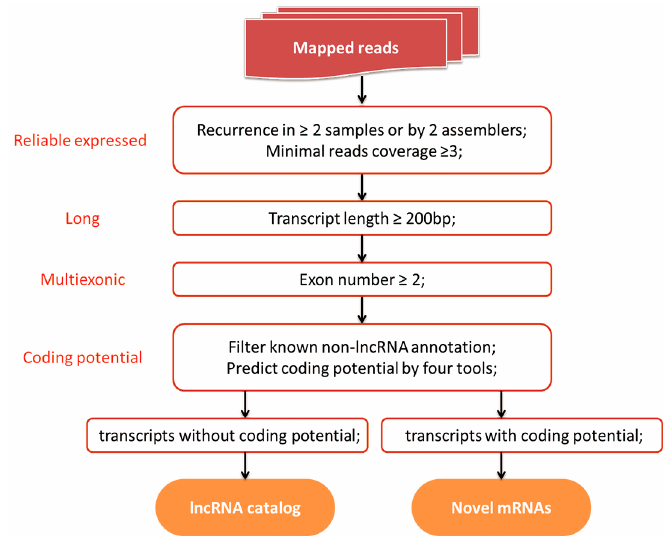
Figure 1. Schematic diagram of the pipeline used in the identification of long non-coding RNAs (lncRNAs) and novel mRNAs. This pipeline took the reads that mapped to the pig reference genome as input data (top). The four criteria required for the identification of lncRNAs are indicated in red. LncRNAs are defined as reliably expressed, long, multi-exonic, and noncoding transcripts. Transcripts that predicted with positive coding potential by any of the four tools (CNCI, CPC, Pfam-scan and PhyloCSF) were considered as novel mRNAs.